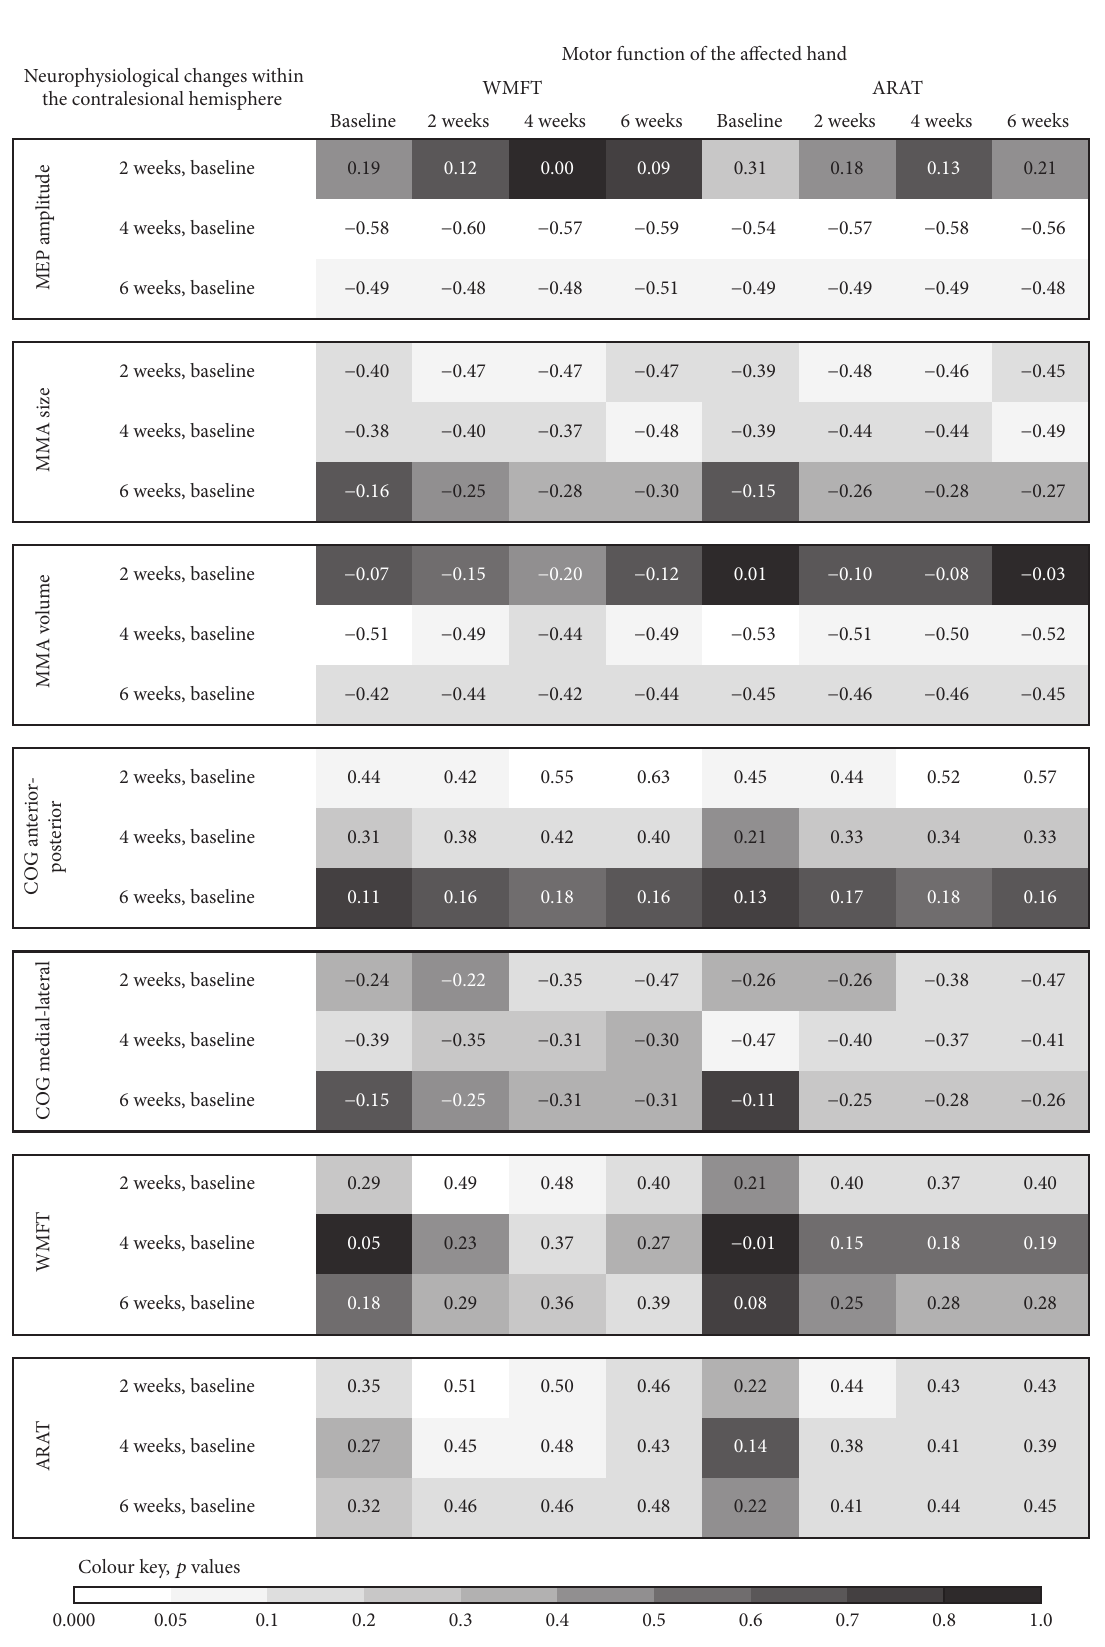
Figure 3: Correlation-coefficients between changes of neurophysiological values within the contralesional hemisphere and motor function of the affected